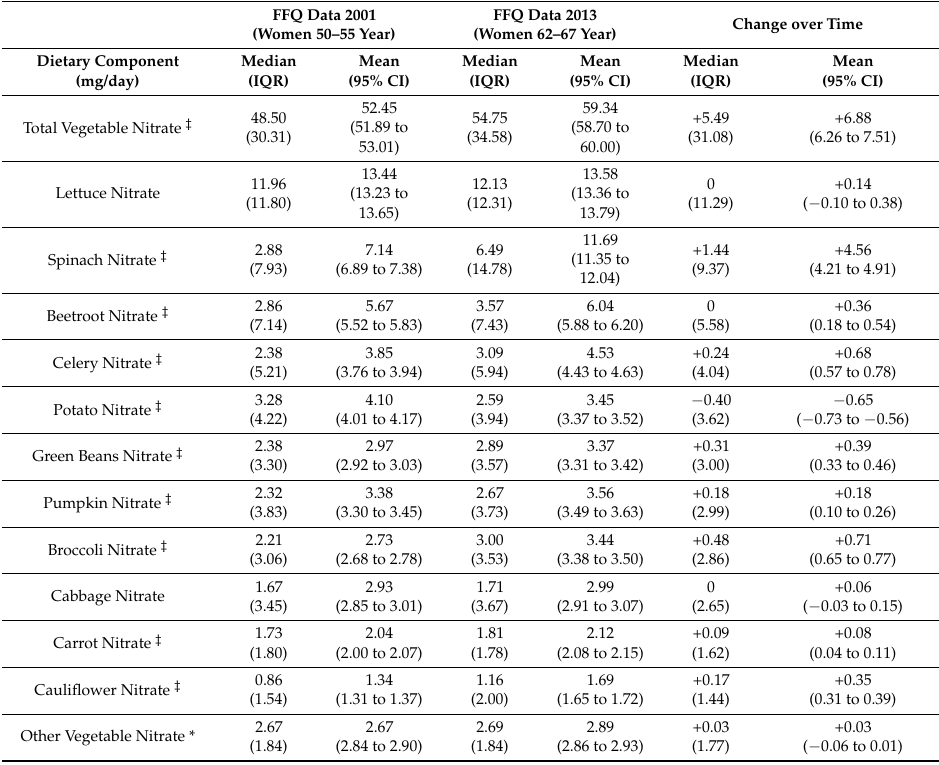
Table 4. Summary and comparison of dietary intakes in 2001 and 2013: Vegetable dietary nitrate consumption by nitrate contributing